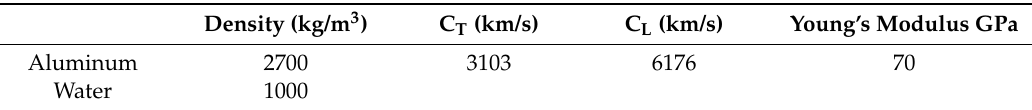
Table 1. Material properties of aluminum and water used in the simulation and experimental measurements.